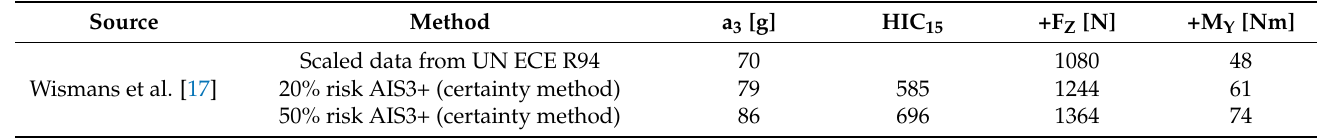
Table 3. Head and neck injury tolerance values for the Q1.5 ATD.